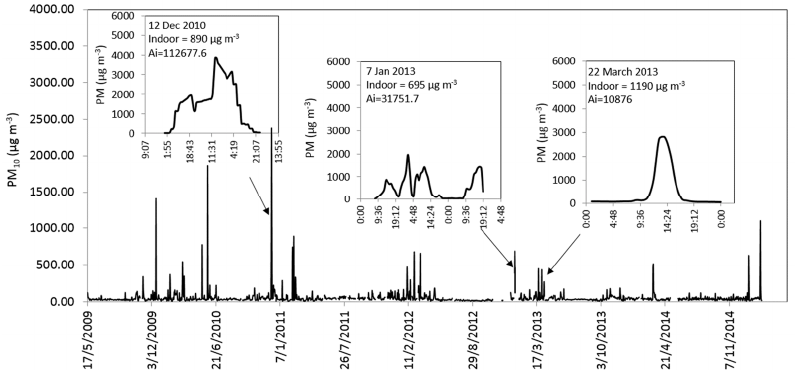
Figure 5. Outdoor PM 10 levels and average indoor PM 10 concentrations during strong dust storms recorded in the northern Negev from 2009 to 2014. The parameter Ai represents storm intensity